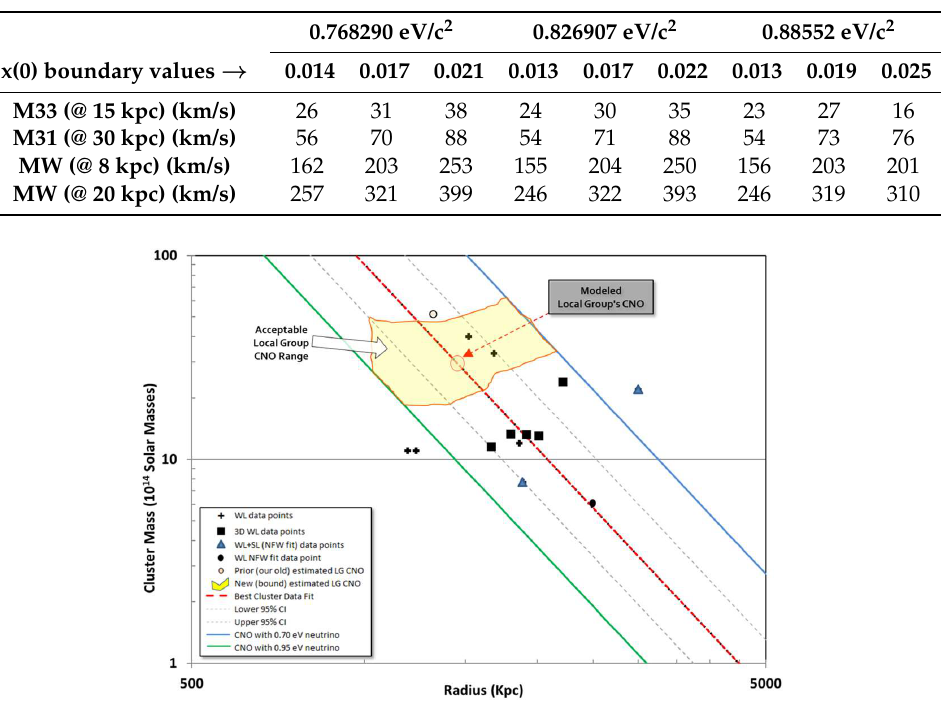
Figure 10. The plotted virial mass and radii from identified weak lensing data now also displaying acceptable Local Group CNO solutions, including the CNO mass and radii values used in Figure 11.